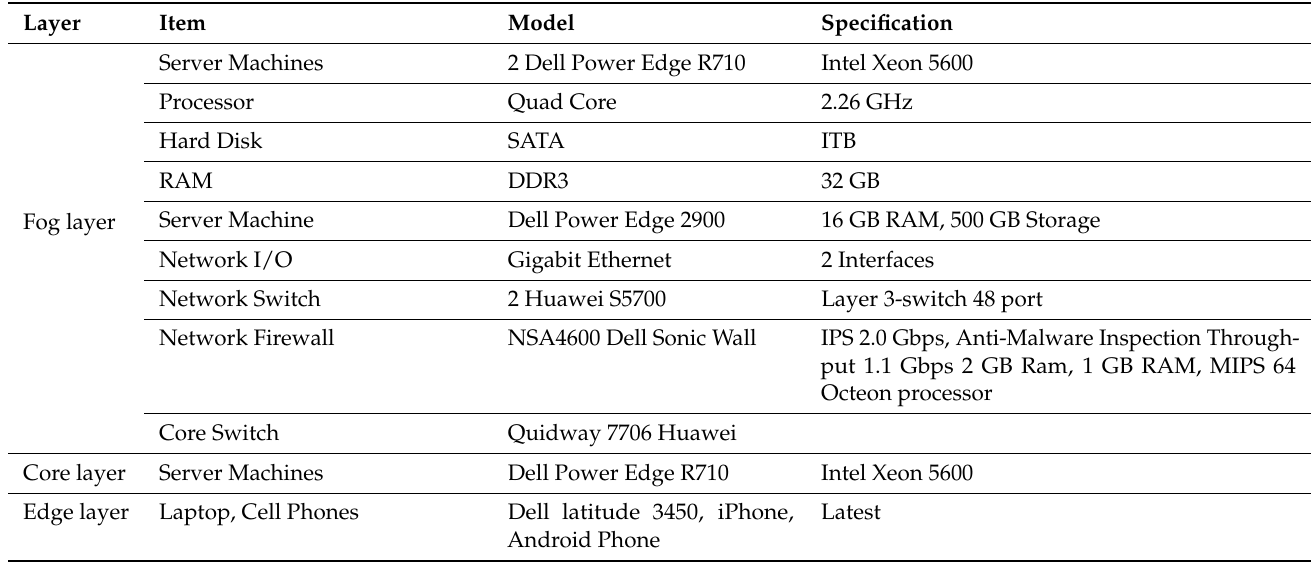
Table 3. Hardware used for the proposed